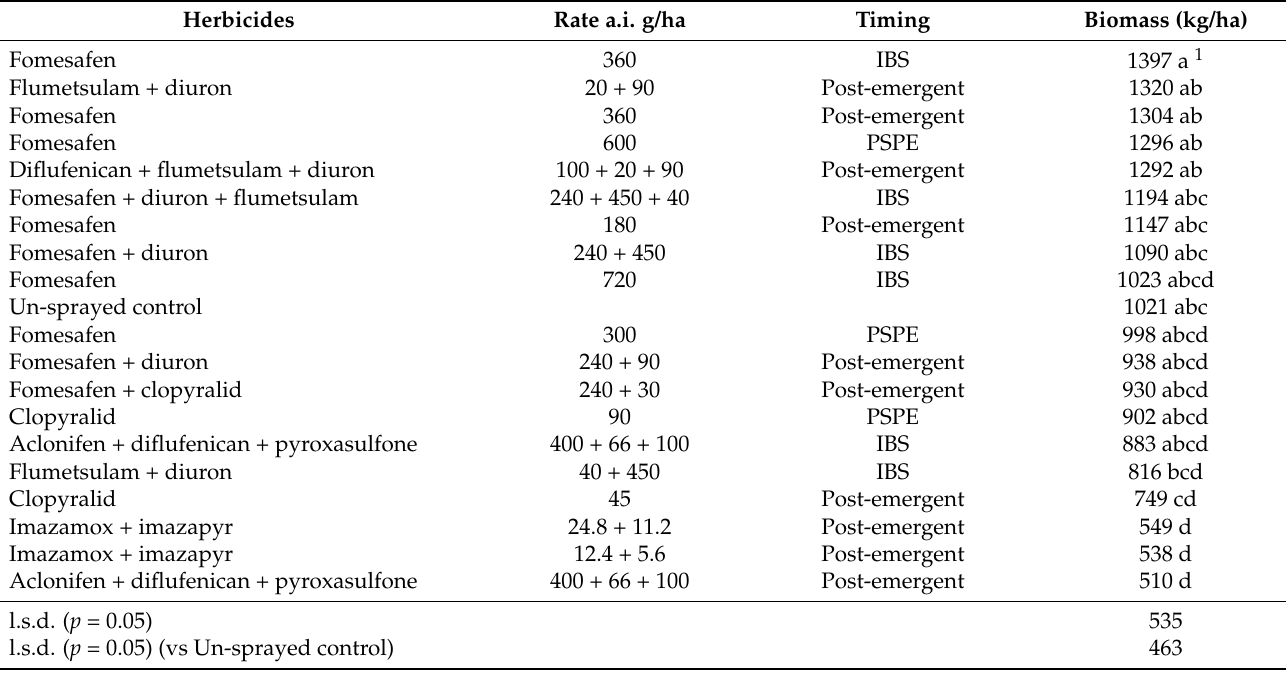
Table 14. Effect of herbicides on tedera biomass (kg/ha) two months after